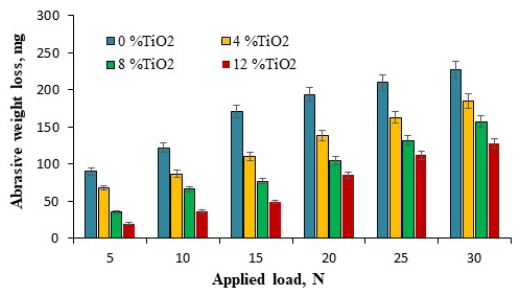
Figure 10. Correlation between abrasive weight loss (mg) and applied loads at different nano-TiO2 contents and sliding distance of 200m.